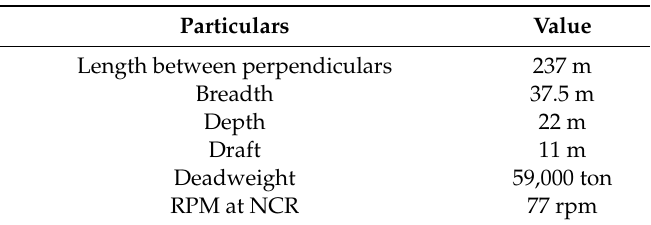
Table 2. Principal particulars of the container ship.